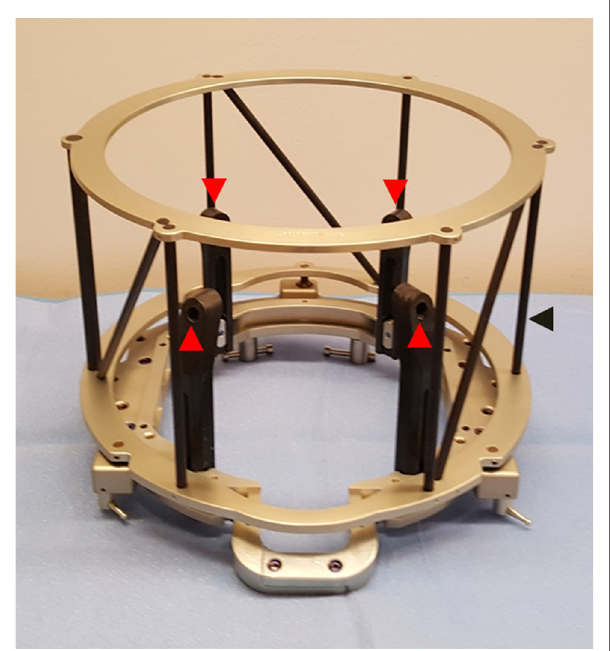
FIGURe 1 | Cosman–Roberts–Wells (CRW) head frame used for rigid fixation to cranium for stereotactic neurosurgery . Frame is affixed to cranium via four screws placed through graphite posts (red arrows). Outer cage (black arrow) serves as a CT localizer for image